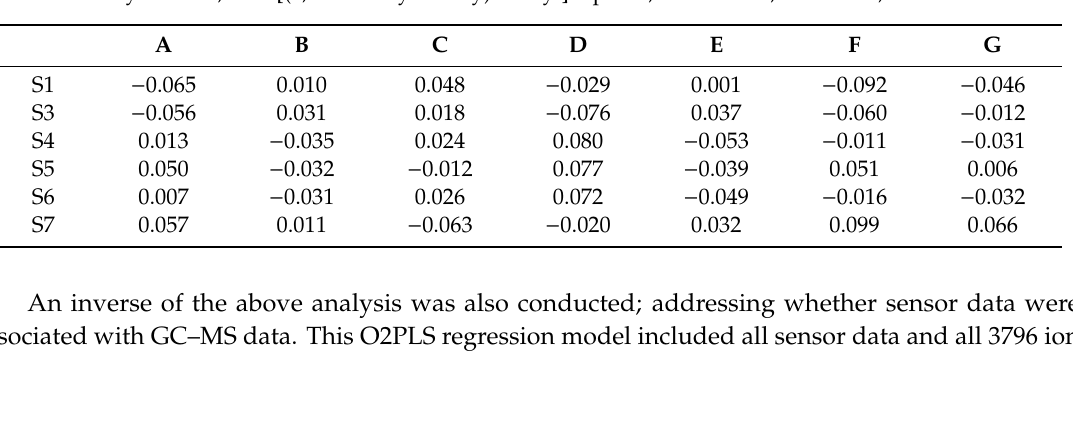
Table 1. Vectors of standardized regression coe ffi cients. Rows: the six eNose sensors included in the O2PLS modelling. Note that sensor array 2 was used to calibrate the signals and therefore not included in the O2PLS. Columns: the seven POT-related exhaled VOCs; A: Cyclohexane, B: